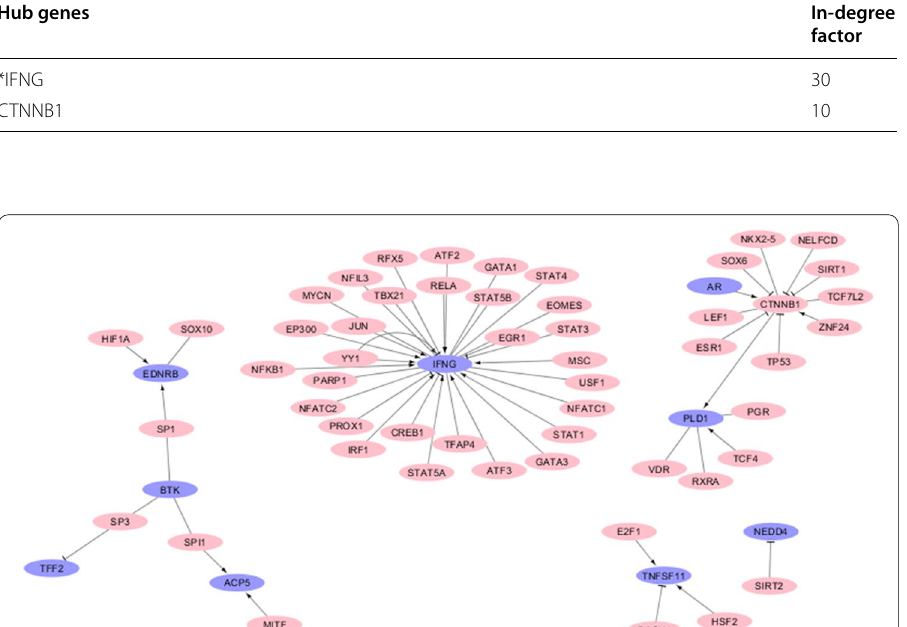
Fig. 5 Tf-gene network involved in chemoresistance process. Upregulated genes are colored in pink while down regulated ones are